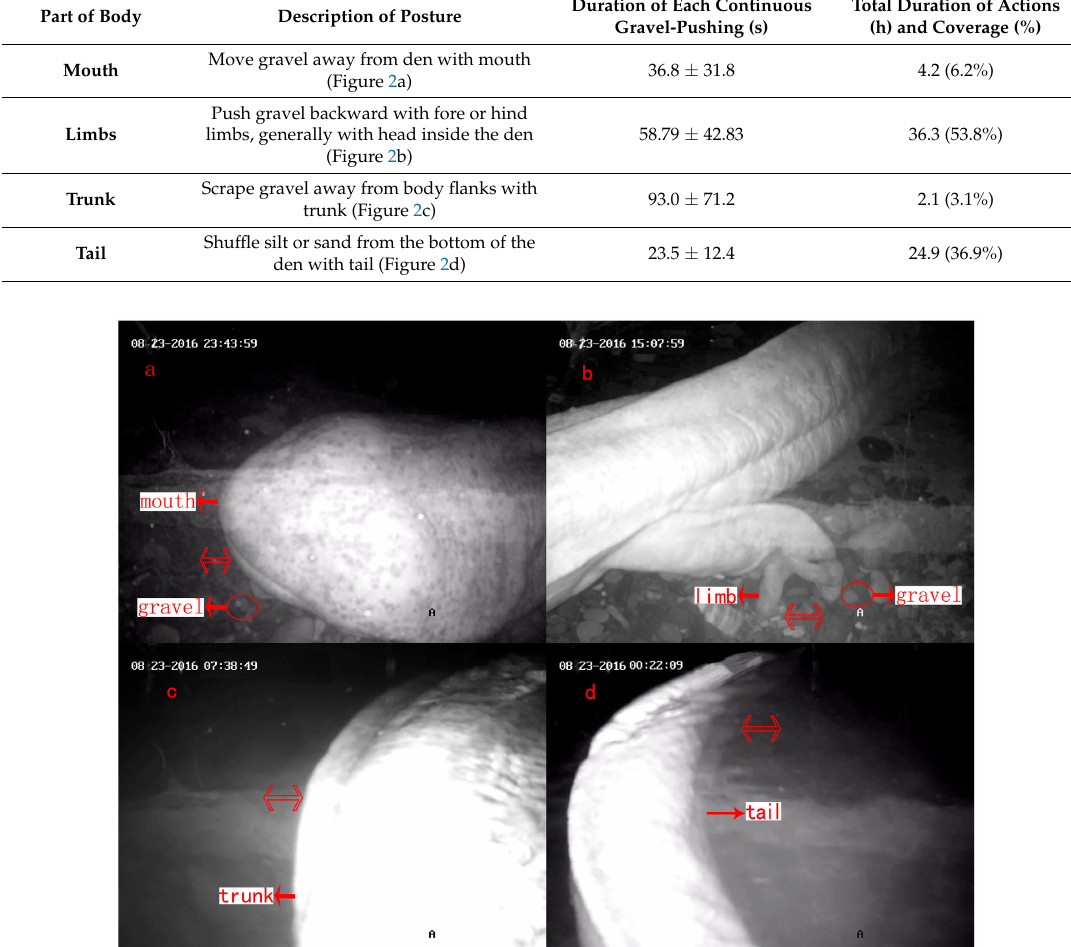
Figure 2. Sand-pushing behavior: gravel was pushed out of the den or to the corner of the den using the mouth ( a ), limbs ( b ), trunk ( c ), and/or tail ( d ). Note: Photos are screenshots of the monitoring video. The two-way arrows on the photos represent the moving direction. This is also true for Figures 3, 5 and